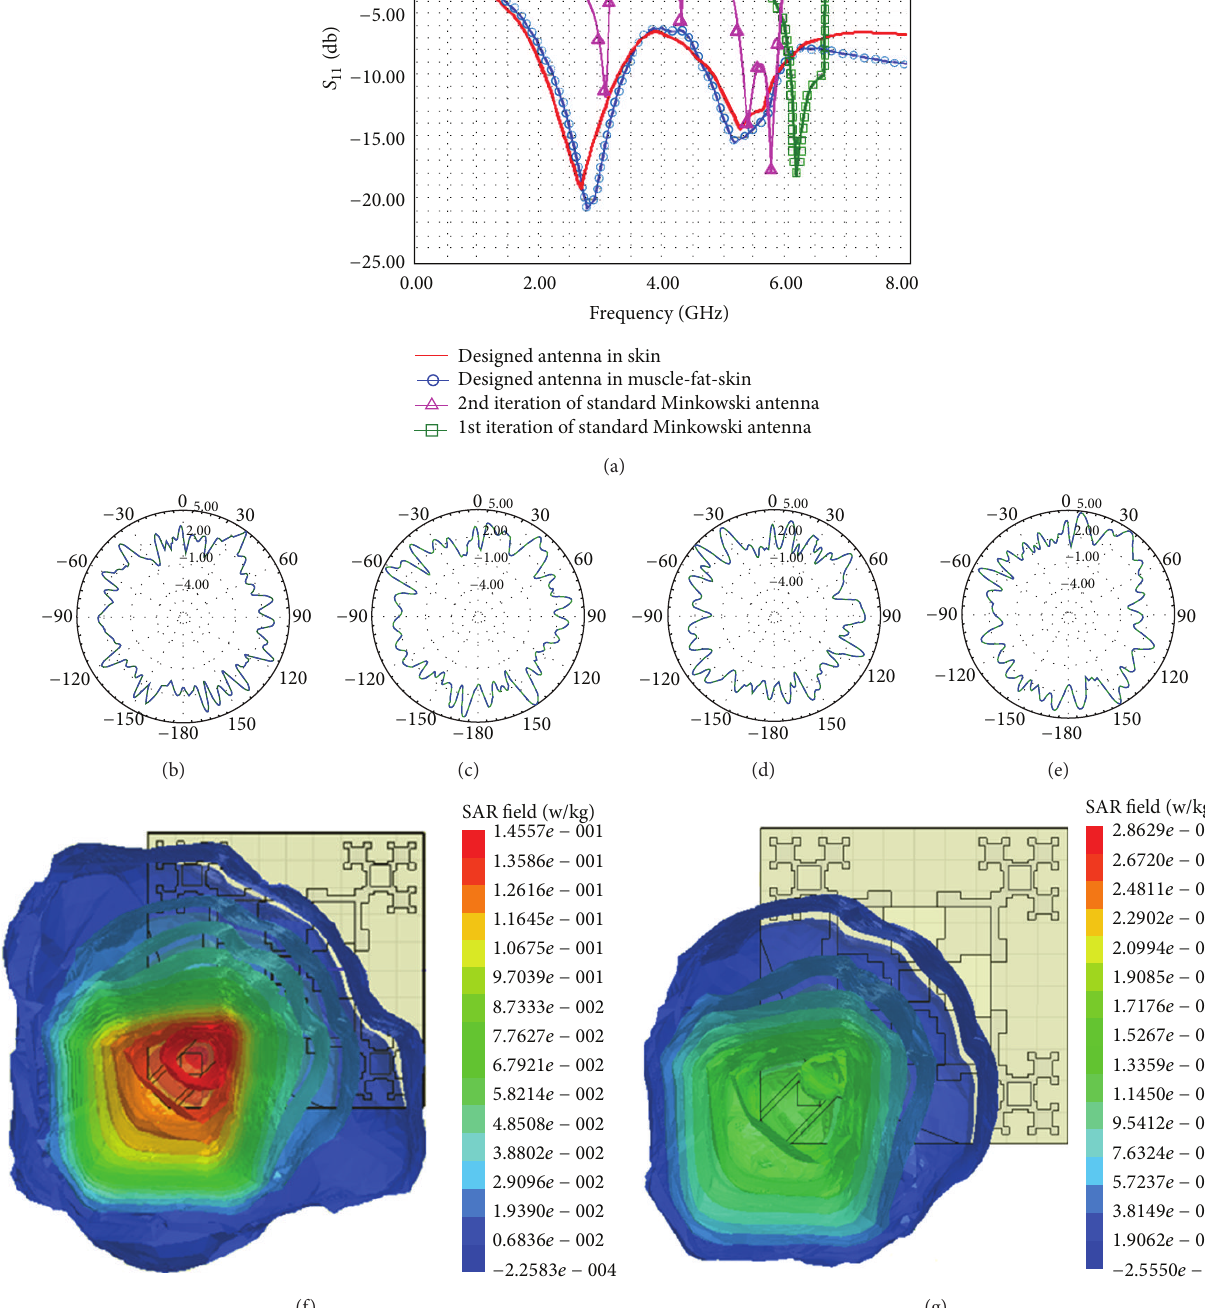
Figure 6: (a) The return losses ( S 11 ) of the designed antenna in human body and the 1st and 2nd iterations of standard Minkowski fractal antenna in skin. (b)–(e) The Gain patterns of the designed antenna plotted in azimuth plane ( 𝜃 = 90 ) at (b) 2.4 GHz and (c) 5.8 GHz and in zenith plane ( 𝜑 = 90 ) at (d) 2.4 GHz and (e) 5.8 GHz. The total SAR from the top view at (f) 2.4 GHz and (g) 5.8 GHz inside the human